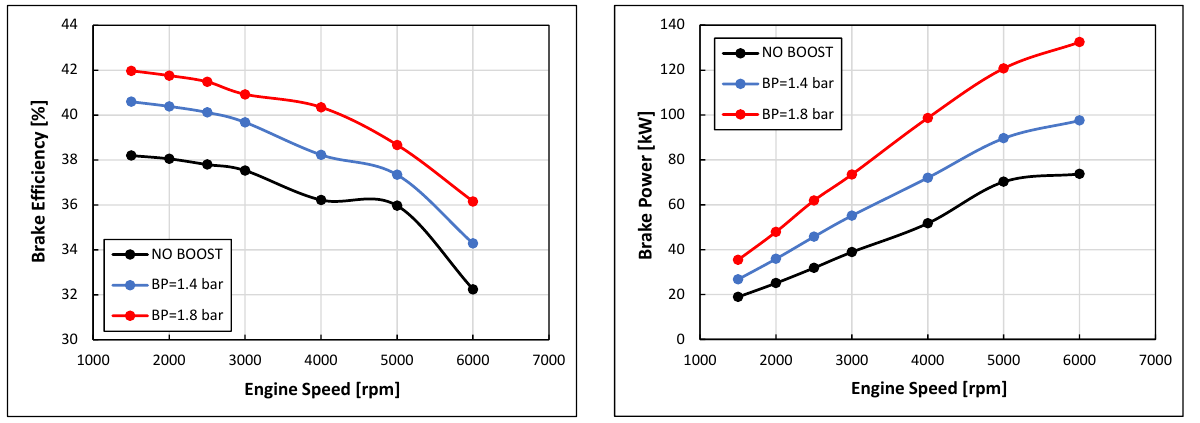
Figure 7. Combustion duration (0–90%) ( left ) and optimal spark advance ( right ) for different boost levels. ϕ = 1. WOT.